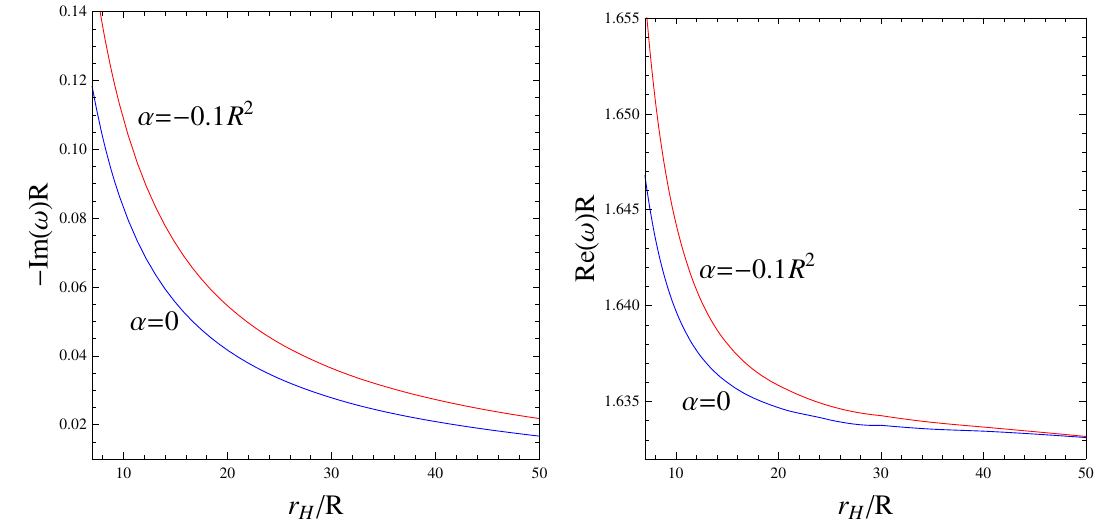
Figure 3 . D = 5, (cid:11) = 0 (blue) and (cid:11) = (cid:0) 0 : 1 R 2 (red): sound mode ( ‘ = 2) as a function of the black-hole radius. In the limit of large black holes Re( ! ) does not depend on (cid:11) (right panel). sound mode equals c k (where c is speed of sound and k is momentum), this may indicate s s that c is una(cid:11)ected by the Gauss-Bonnet coupling (cid:11) . Indeed, this is also con(cid:12)rmed by s the calculations for black branes (see eq. 3.25 in